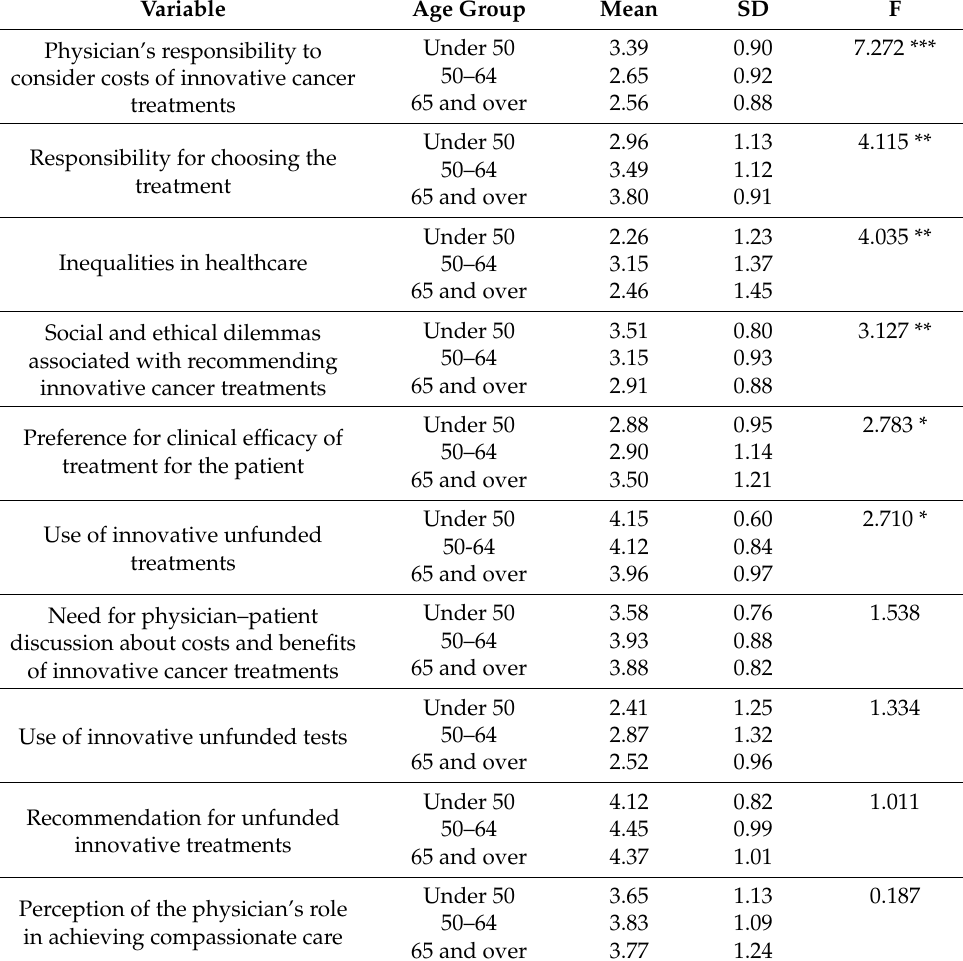
Table 4. Analysis of variance for comparisons between age groups regarding the study